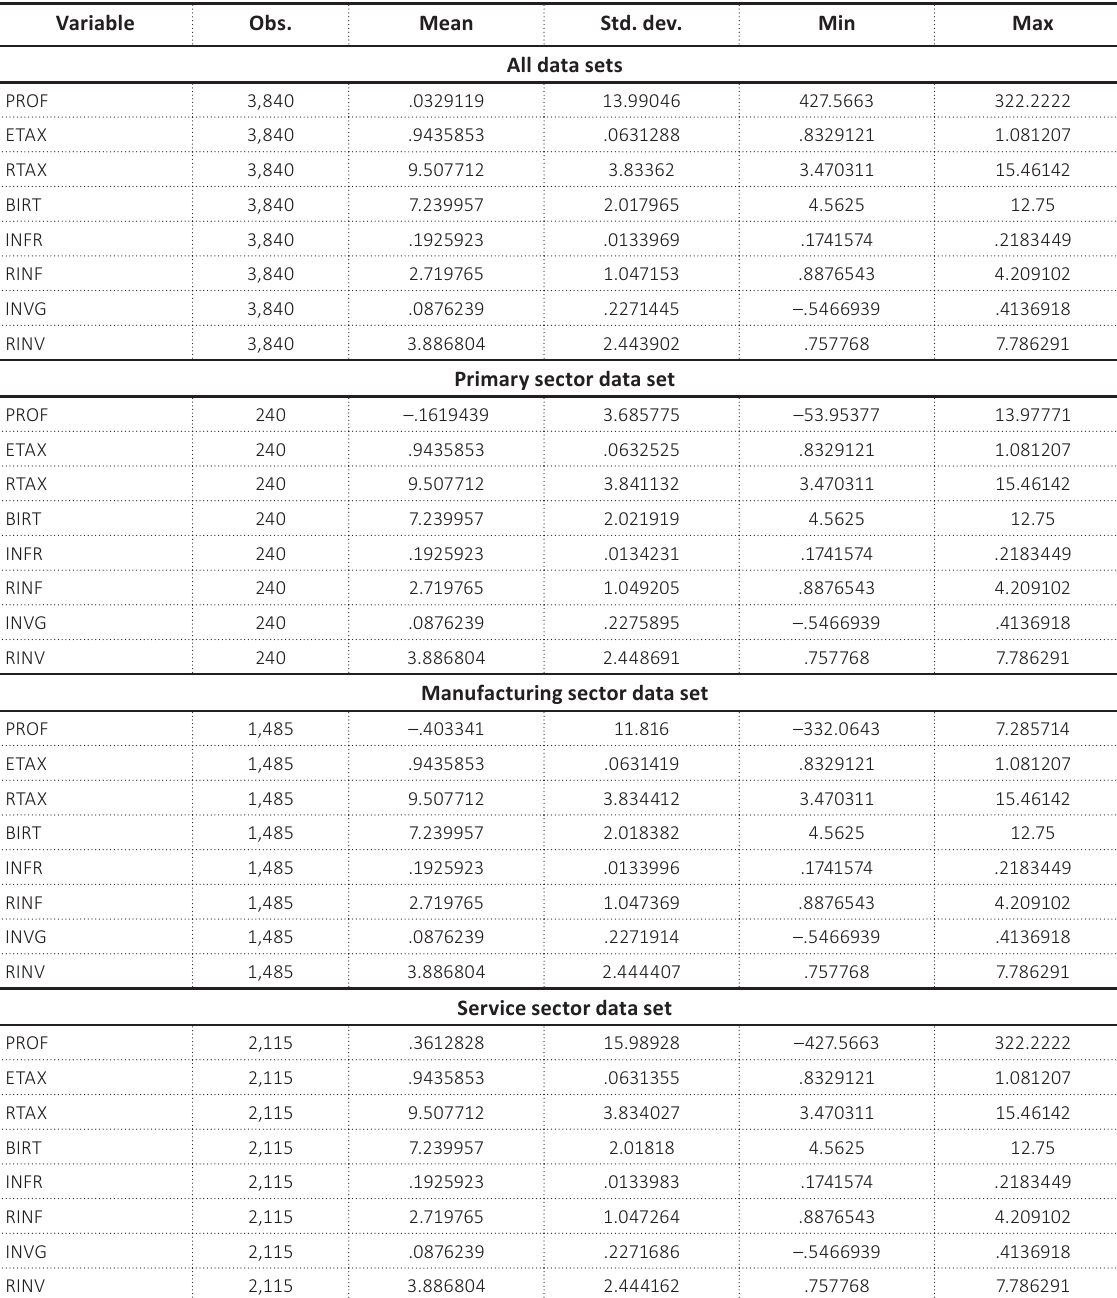
Table 2. Descriptive statistics of each